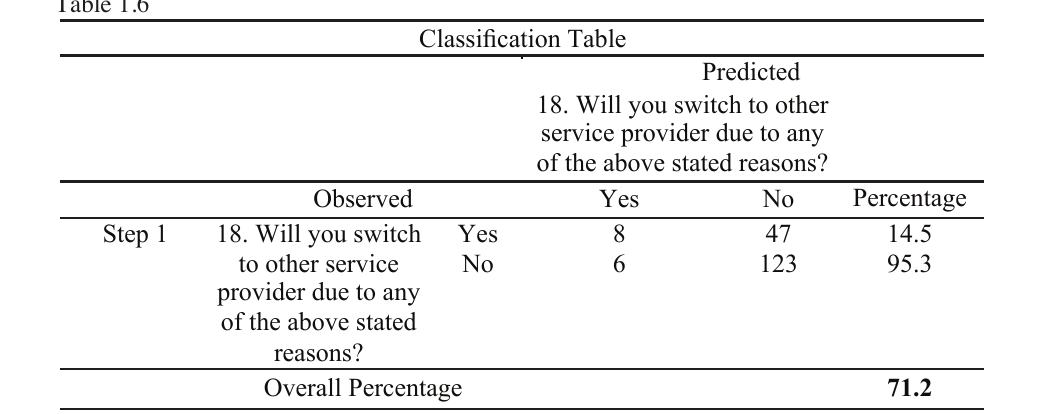
Step 1 205.850a .096 .136